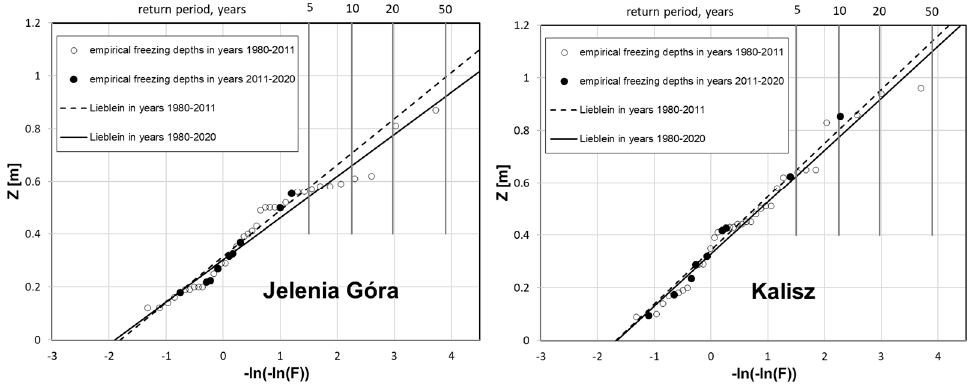
Figure 7. Comparison of predicted and measurement value for chosen location: Bia ł ystok ( left ) and Elbl ą g ( right ) station.